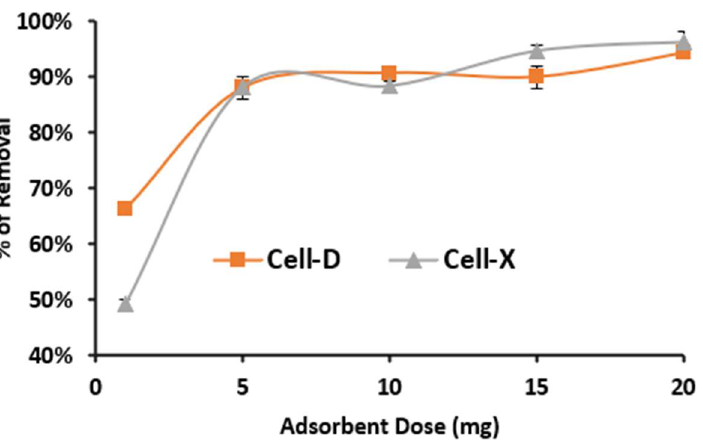
Figure 8. Effect of adsorbent dose on adsorption efficiency of Cell-X and Cell-D. (Volume: 10 mL, 20 °C, pH: 6 and 8 for Cell-X and Cell-D, respectively).